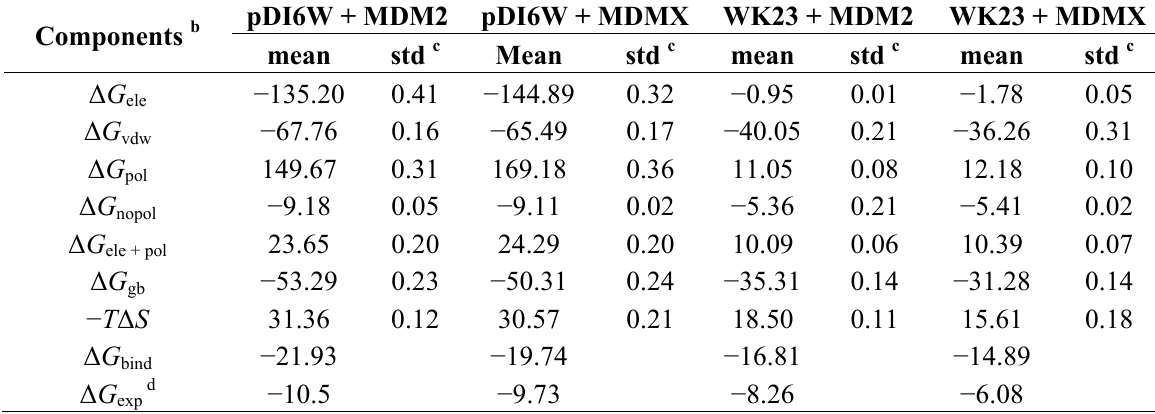
Table 1. Binding free energies computed by MM-GBSA method a